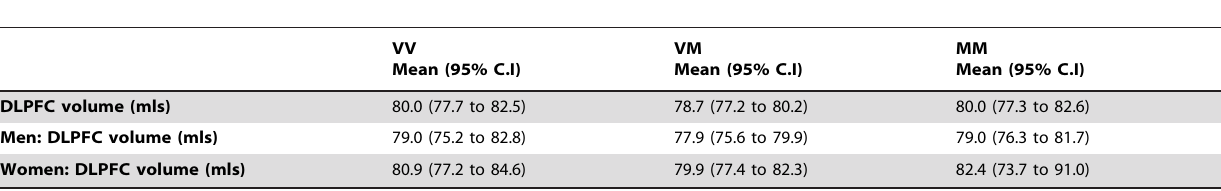
Table 2. DLPFC volume according to